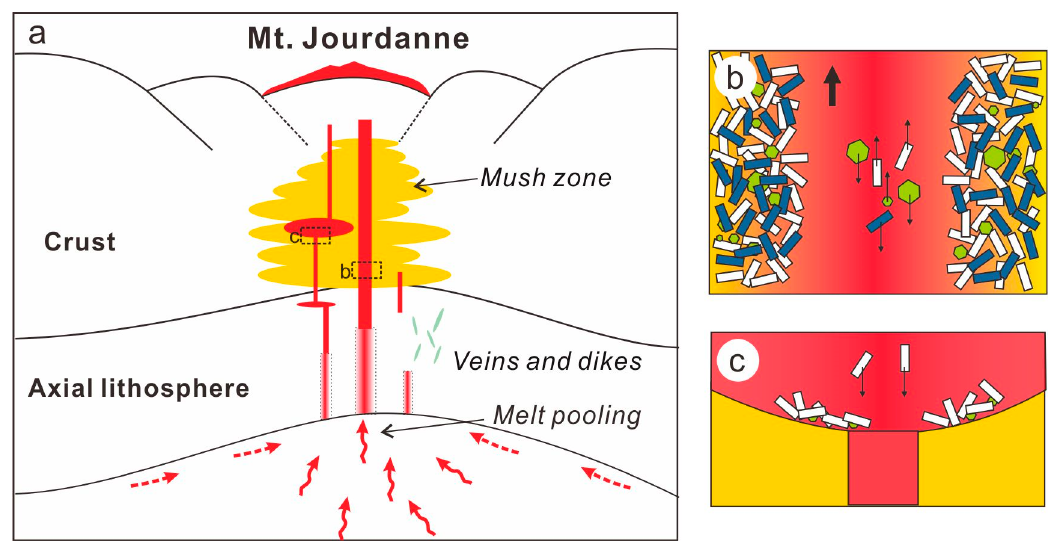
Figure 12. Cartoon showing the magma plumbing system beneath Mount Jourdanne massif with a model for the petrogenesis of the PUBs. ( a ) Sketch showing the melt extraction, melt / rock reaction and migration through the gabbroic mush zone at the crustal level. During melt extraction, the melts derived from the hybrid mantle sources pool at the base of axial lithosphere. The dashed arrows show the low degrees of partial melts migrating along the base of lithosphere in a high porosity channel. When the melt is percolating through the lithosphere, the melt / mantle reaction occurs mainly in the walls of melt conduits. Subsequent fractional crystallization of melts may occur in the shallow melt lens. Meanwhile, the veins and dikes may also form at shallow levels in the brittle lithosphere. ( b ) Upward migration of a new batch of magma disturb the gabbroic mush, resulting the rapid segregation of minerals by density contrast. The plagioclase incorporation in the lower crust is aided by the small di ff erence of density contrast between magma and plagioclase. The ascent rate of magma is high enough to overcome the settling velocity of plagioclase, but not fast enough to carry denser clinopyroxene and olivine. ( c ) When a plagioclase-bearing melt enters a shallow magma reservoir, the upward velocity decreases to zero, resulting in the sinking of plagioclase and hence the PUBs will never be erupted at the seafloor. White rectangles, plagioclase; blue rectangles, clinopyroxene; green hexagons,